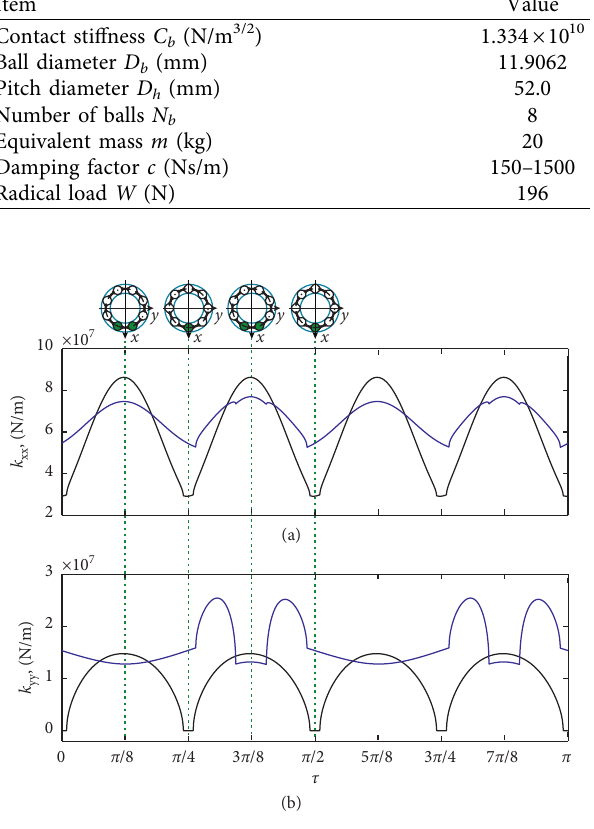
Figure 2: System dynamic stiffness of period-1 (black line) and period-2 (blue line) motions for X ( τ ) for δ 0 � 6.0 μ m and c � 200Ns/m when Ω �